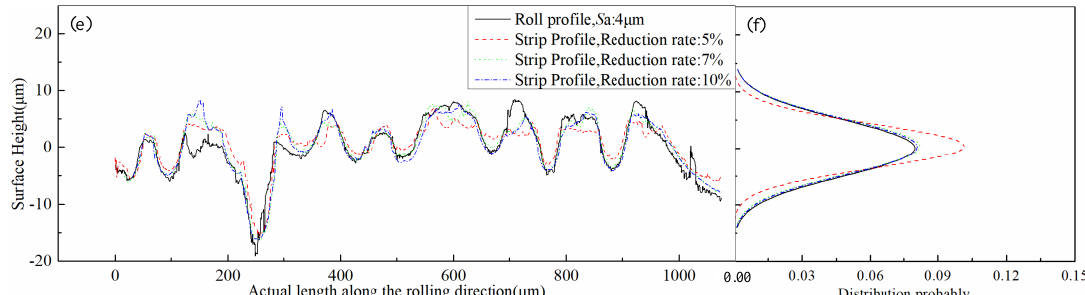
Figure 10. Surface topography of roll and strip under different roll roughness and reduction rates along the rolling direction: ( a ) profile of roll and strips (3μm roll roughness, 5/7/10% reduction), ( b ) height distribution of roll and strips (3μm roll roughness, 5/7/10% reduction), ( c ) profile of roll and strips (3.5μm roll roughness, 5/7/10% reduction), ( d ) height distribution of roll and strips (3.5μm roll roughness, 5/7/10% reduction), ( e ) profile of roll and strips (4μm roll roughness, 5/7/10% reduction), ( f ) height distribution of roll and strips (4μm roll roughness, 5/7/10% reduction).